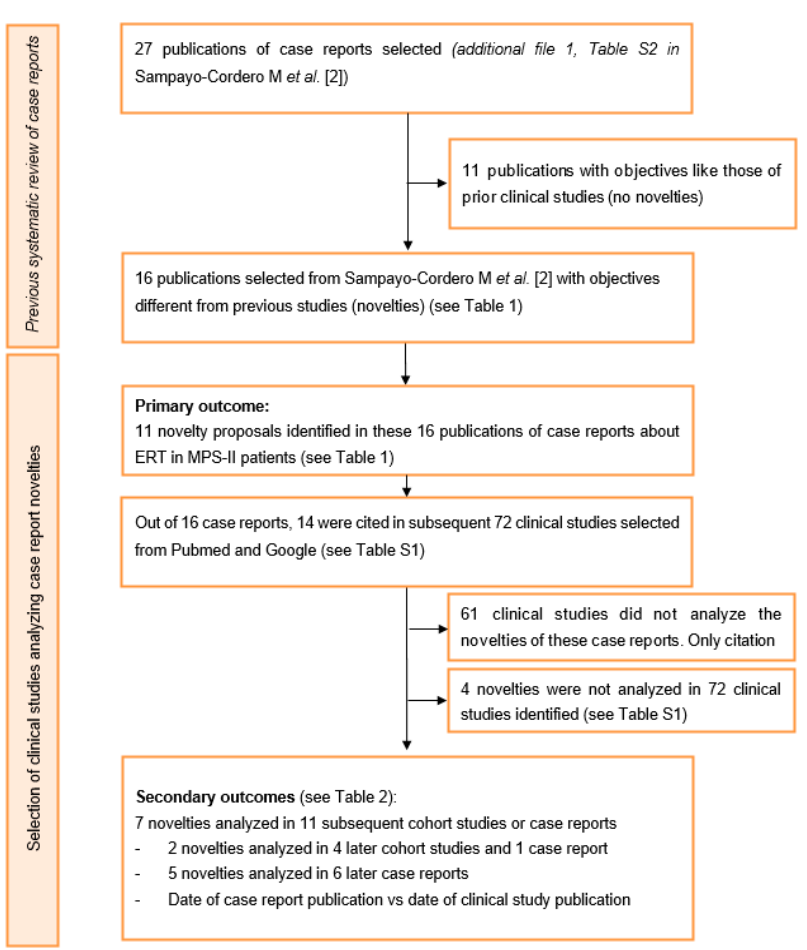
Figure 1. Flow of case reports that evaluated the efficacy and safety of enzyme replacement therapies in mucopolysaccharidosis type II (<2016). ERT—Enzyme replacement therapy; MPS— Mucopolysaccharidosis.